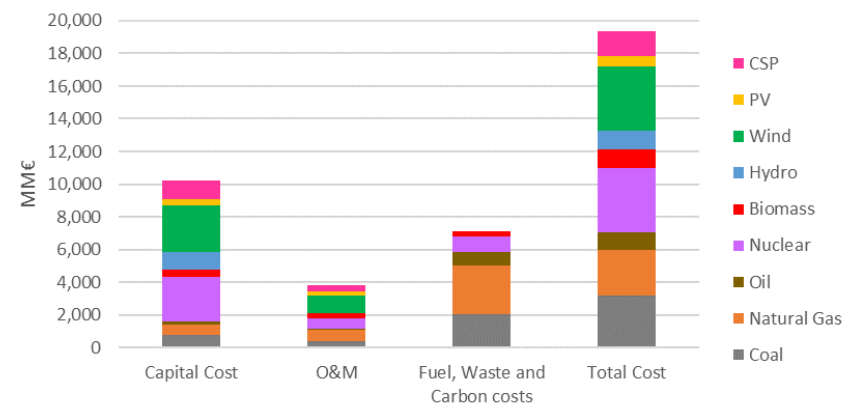
Figure 11. Contribution of di ff erent technologies to the aggregated LCOE of Spain in 2015